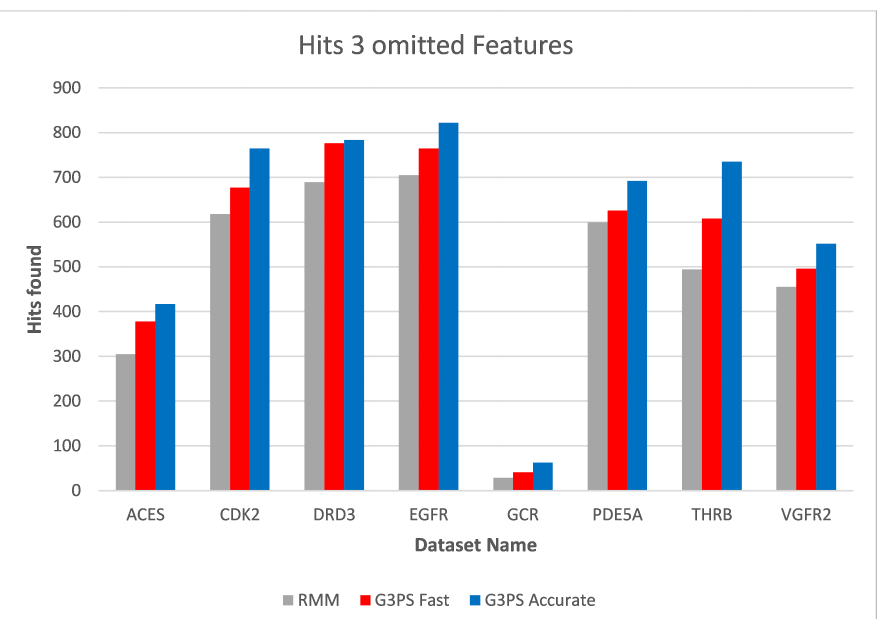
Figure 17. Screening benchmark hits with three omitted